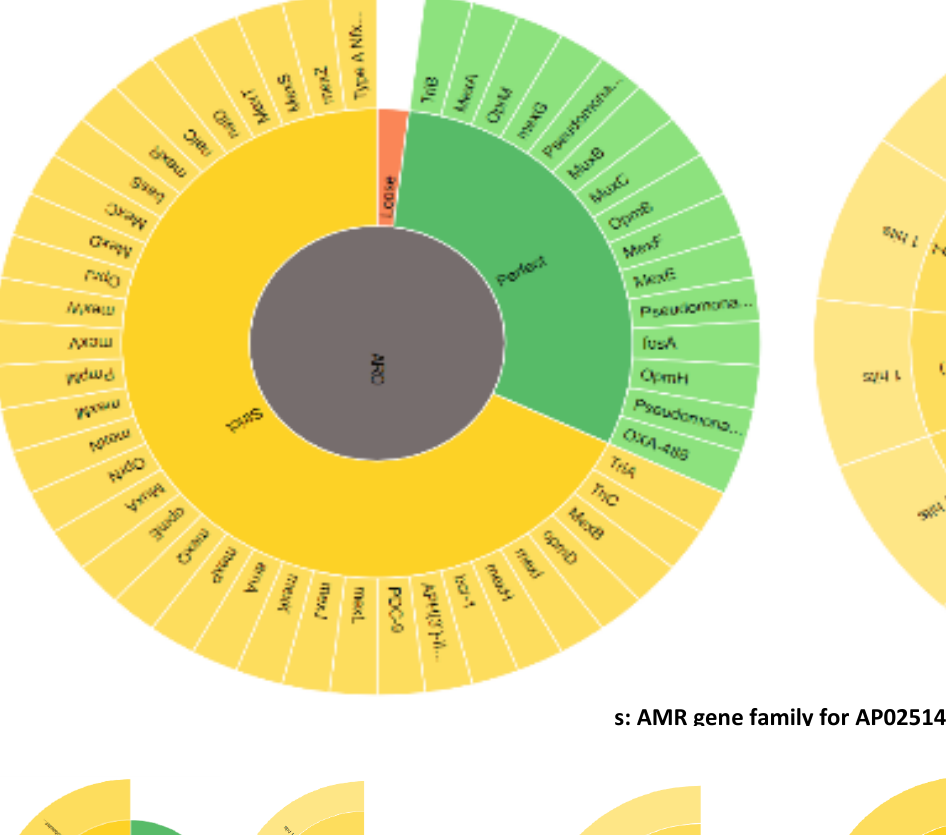
s: AMR gene family for AP025149.2